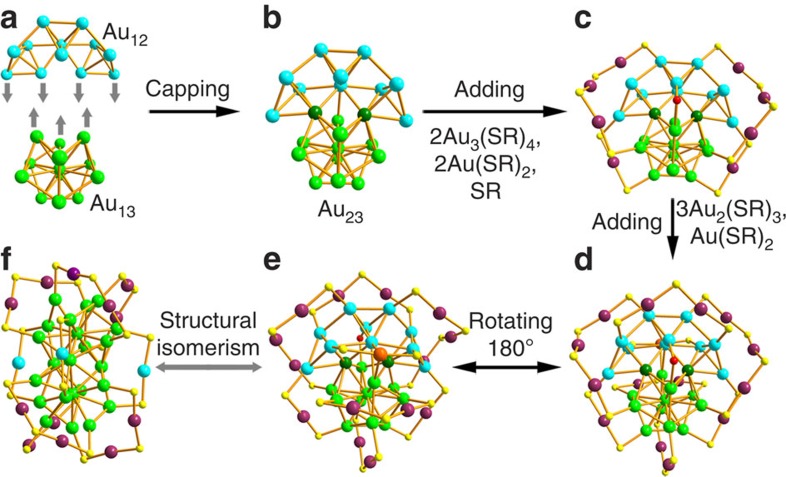
Structures of Au38T and Au38Q.(a) Anatomy of the Au23 core, which consists of a Au12 cap unit and Au13 icosahedral unit. (b) Au23 core, which is constructed by one Au12 unit and one Au13 unit sharing two gold atoms. (c) Two Au3(SR)4, two Au(SR)2 and one SR linking the Au12 cap and Au13 icosahedron. (d) Three Au2(SR)3 and one Au(SR)2 protecting the Au23 core. (e) Back view of Au38T. (f) The Au38Q structure.